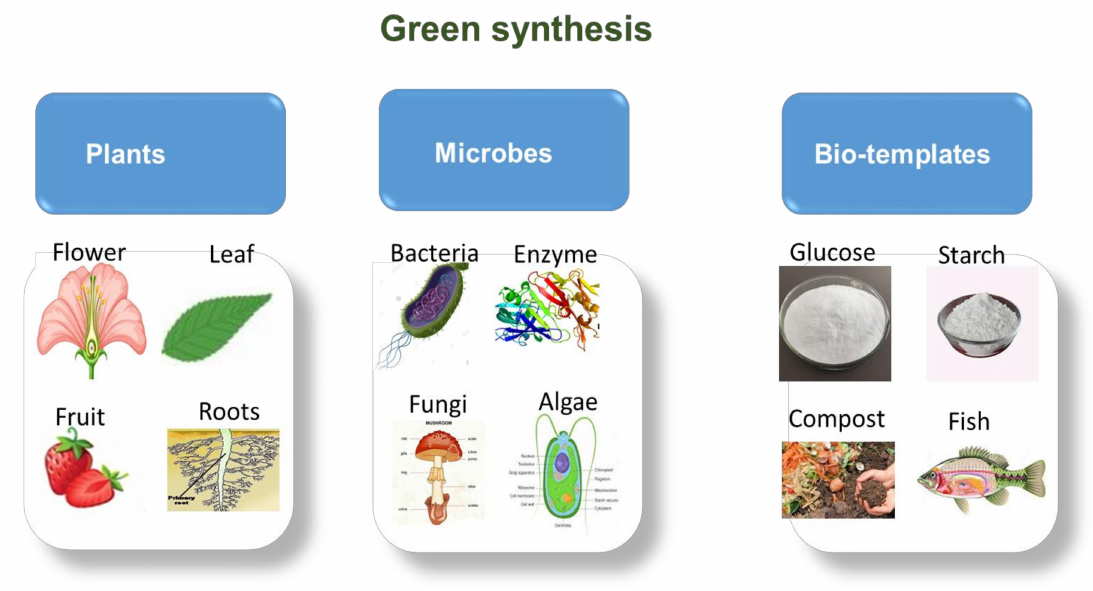
Figure 8. Various (plants, microbes and biotemplates) green synthesis